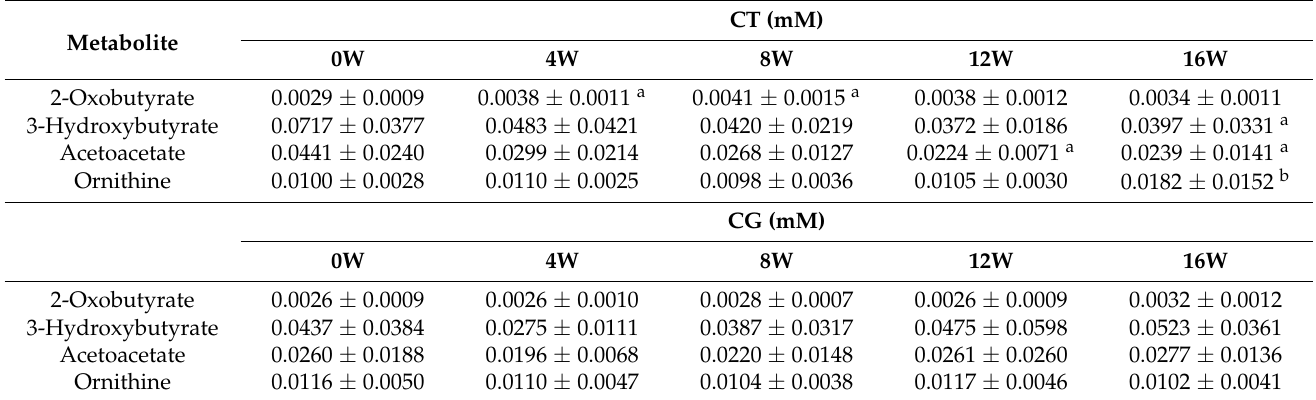
Figure 2. Partial least squares discriminant analysis (PLS-DA). Control Group (CG) is represented by the square ( ☐ ) and the Combined Training (CT) is represented by the circle ( ◯ ). Colours vary according to the time of data collection; 0W = green: baseline; 4W = pink: 4 weeks; 8W = yellow: after 8 weeks of training; 12W = red: after 12 weeks of training; 16W = blue: after 16 weeks of training. The present model used data for all 66 metabolites detected. Table 3. Metabolites that showed significant differences in a linear mixed model